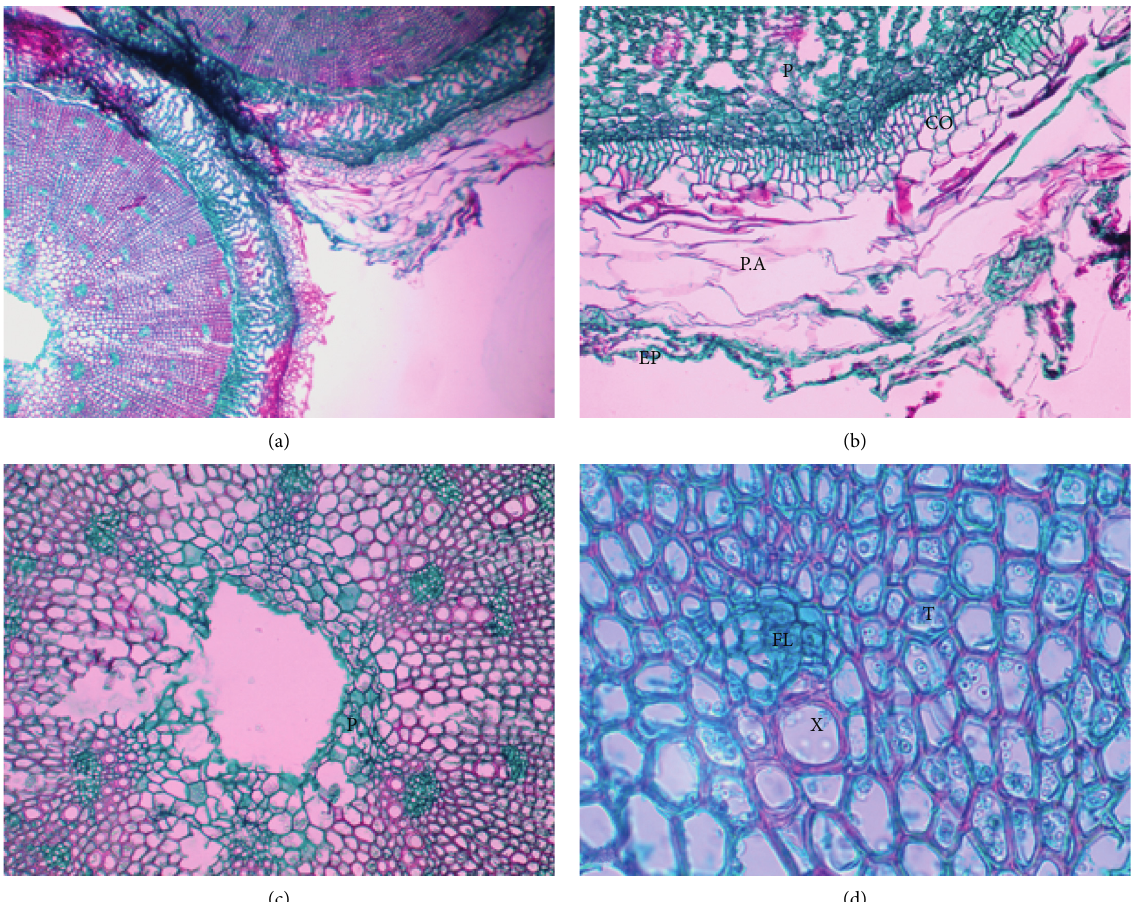
Figure 6: Image of cross-section of the stem from specimen from the Puchuncav´ı commune. Stem full view, 4X magnification (a); epidermis (EP), Aquifer parenchyma, collenchyma (CO), and parenchyma (P), 10X magnification (b); parenchyma (P), 10X magnification (c); vascular bundle (phloem and xylem) and tracheids (T) in 40X magnification